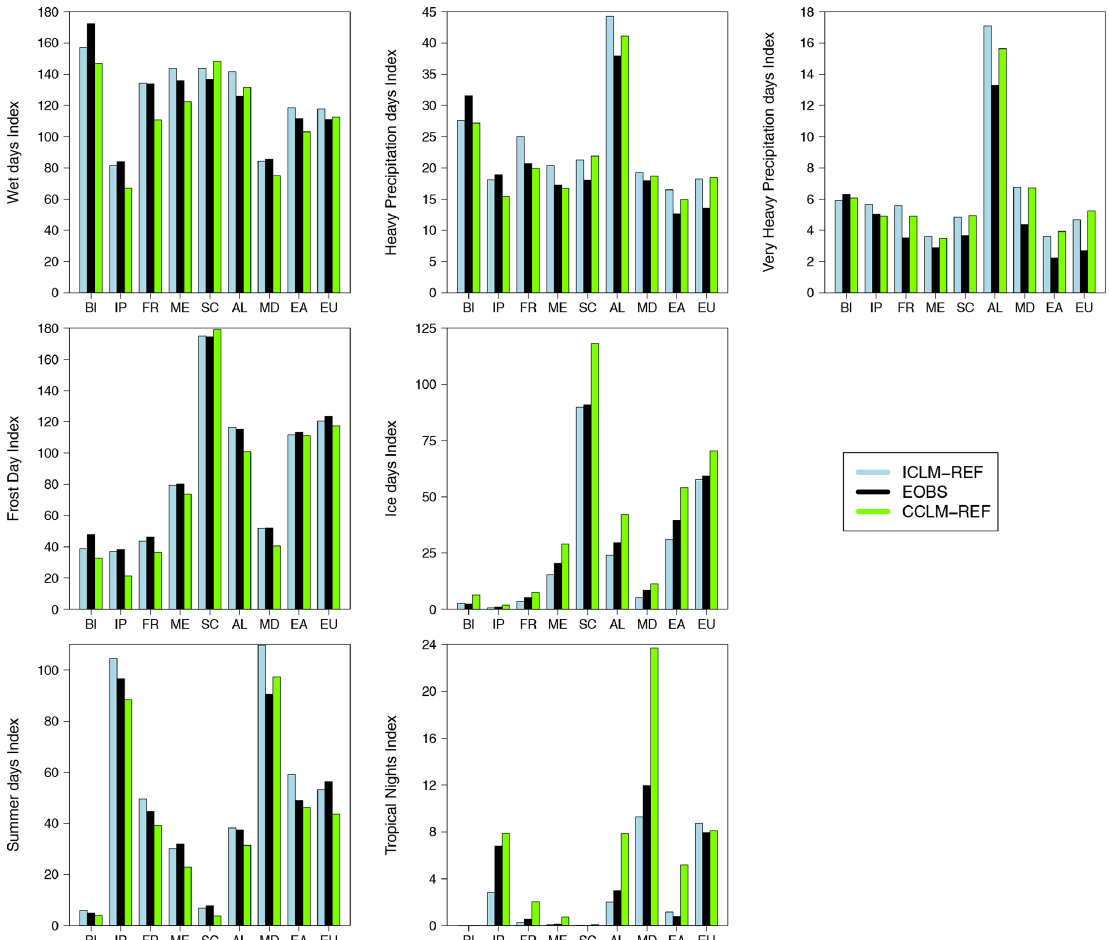
Figure 11. Area mean of climate indices [days per year] calculated from daily maximum and minimum air temperature and daily precipitation data of ICLM-REF, CCLM-REF and E-OBS for the PRUDENCE subregions and for all of Europe (denoted EU) averaged over the period 1981–2000.